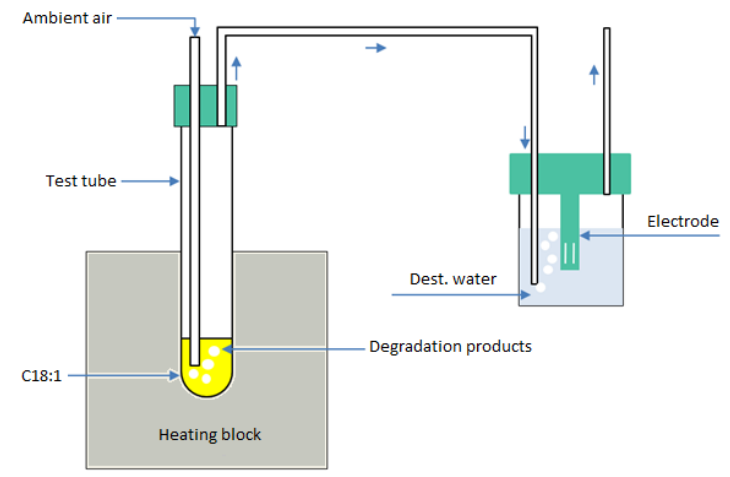
Figure 3. Schematic illustration of the experimental set-up (rancimate) according to DIN EN 14112.